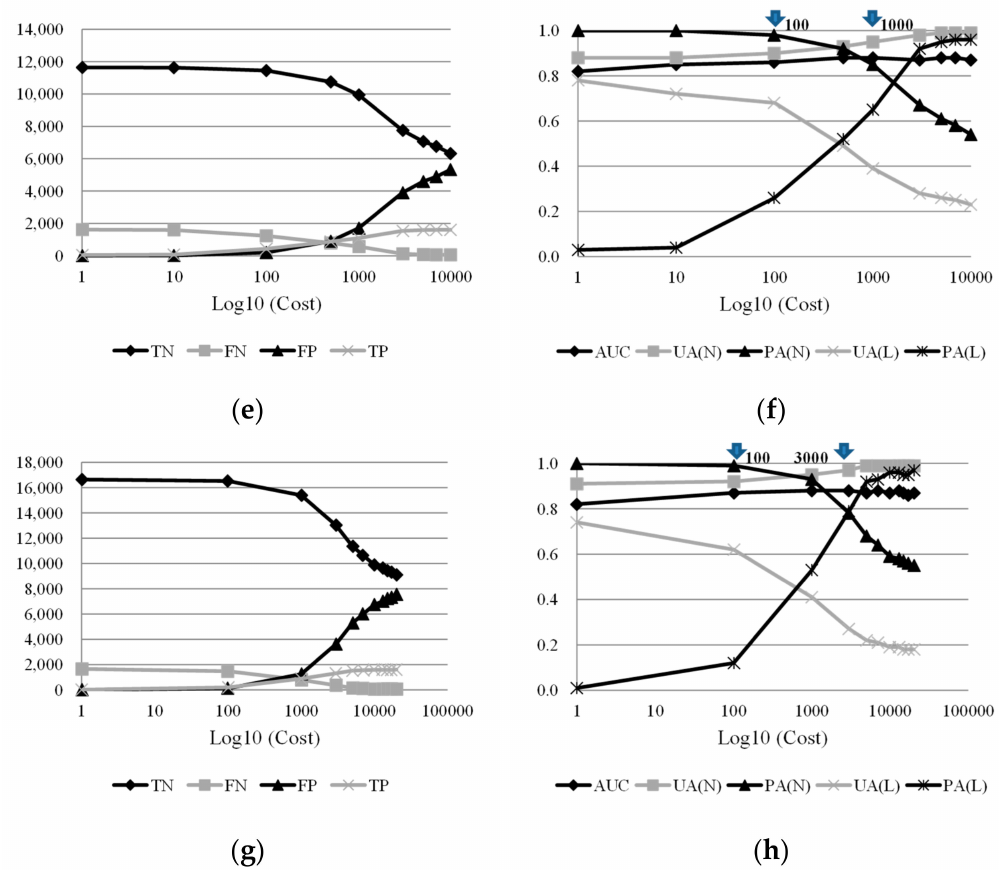
Figure 5. Counts in confusion matrices (left columns, Y axis: counts) and quantitative accuracies (right columns, Y axis: accuracies) of predicting the 2008 dataset using the RF algorithm with cost-sensitive analysis in di ff erent sample proportion cases, where TN, FN, FP, TP, AUC, L, and N indicate true negative, false negative, false positive, true positive, and area under ROC curve, landslide class, and non-landslide class, respectively. ( a ), ( b ) L:N = 1:1; ( c ), ( d ) L:N = 1:4; ( e ), ( f ) L:N = 1:7; ( g ), ( h ) L:N =